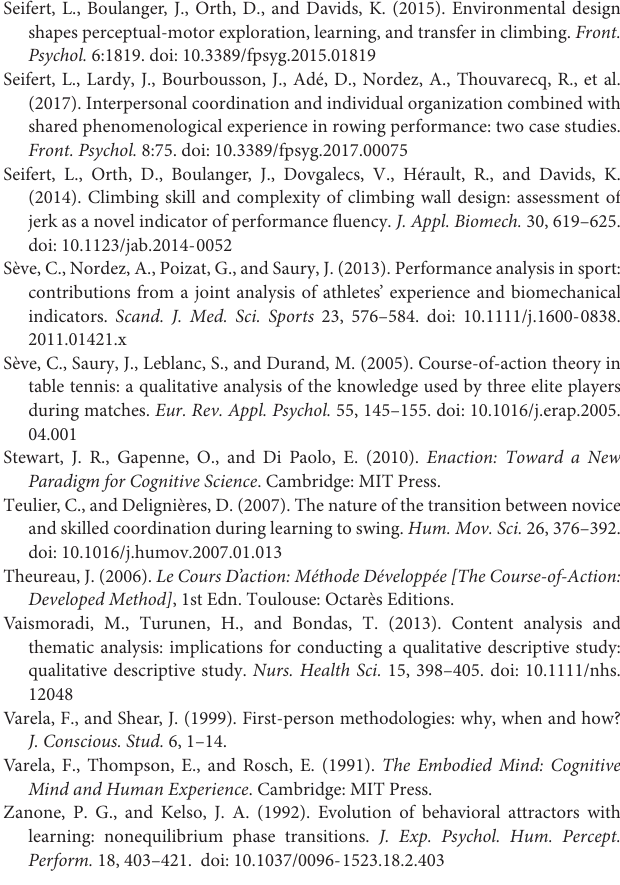
table tennis: a qualitative analysis of the knowledge used by three elite players during matches. Eur. Rev. Appl. Psychol. 55, 145–155. doi: 10.1016/j.erap.2005. 04.001 Stewart, J. R., Gapenne, O., and Di Paolo, E. (2010). Enaction: Toward a New Paradigm for Cognitive Science . Cambridge: MIT Press. Teulier, C., and Delignières, D. (2007). The nature of the transition between novice and skilled coordination during learning to swing. Hum. Mov. Sci. 26, 376–392. doi: